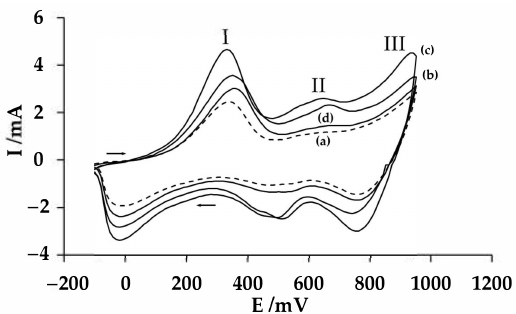
Figure 10. Voltammetric responses of the PAni deposited on the membranes with the following PSS concentrations in solution: (a) 0, (b) 5, (c) 20, and (d) 40 mM of PSS in 1 M H 2 SO 4 1 M at a 100 mV / s scan